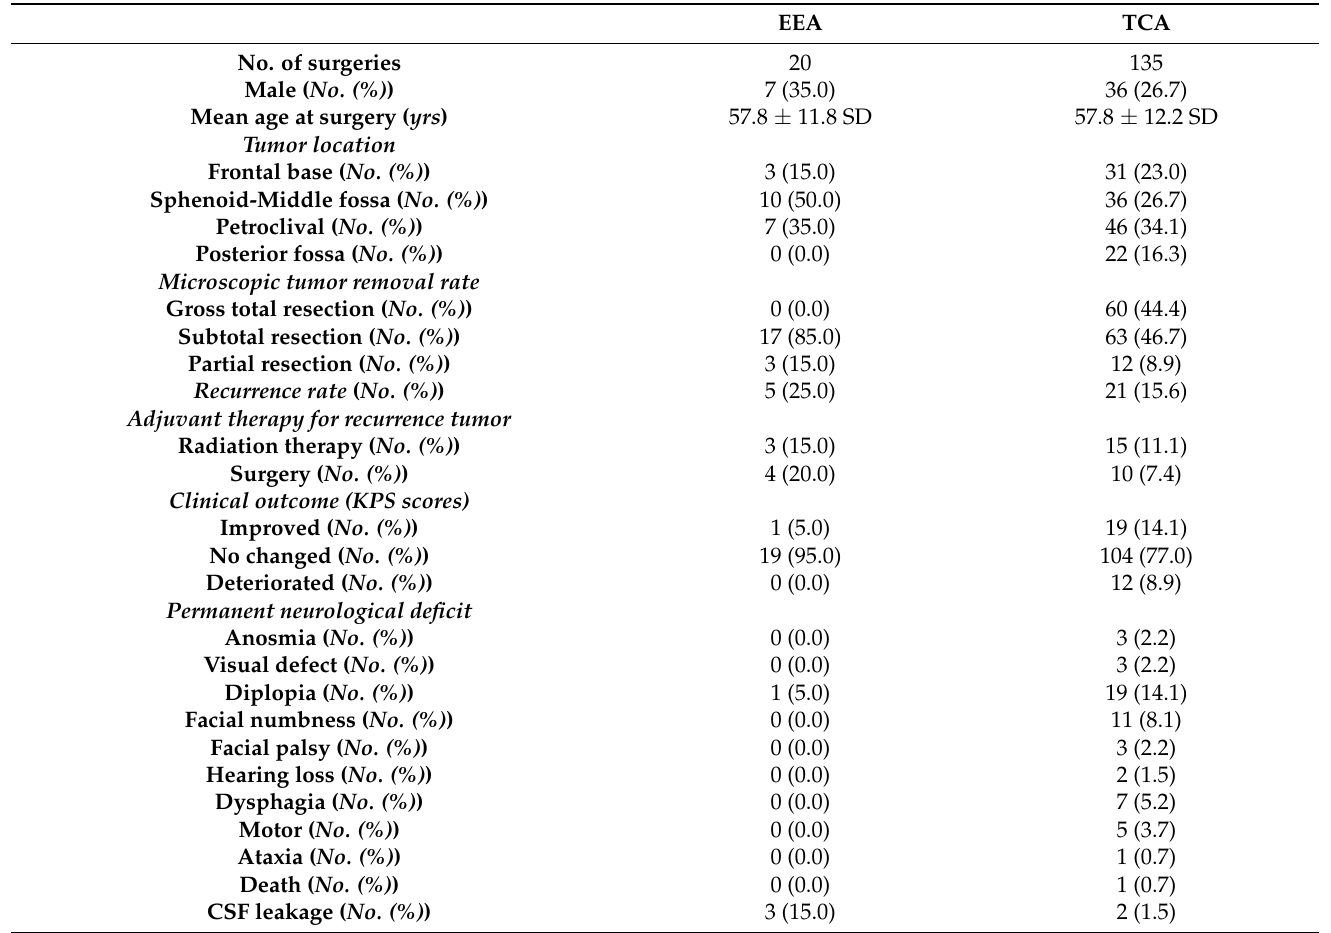
Table 1. Characteristics of patients who underwent surgery for WHO grade 1 skull base meningiomas between January 2014 and December